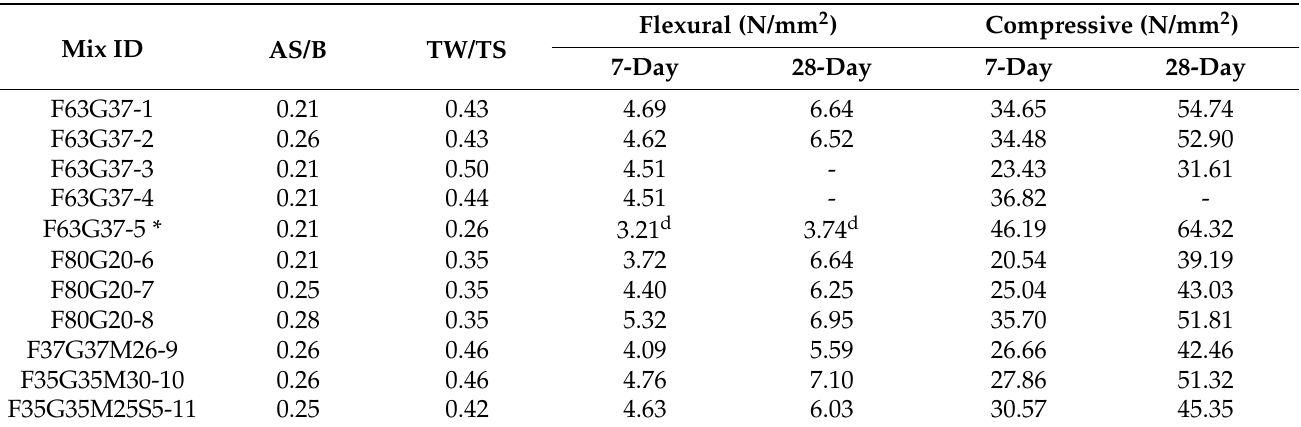
Table 2. Details of mix proportions and results for FA-based